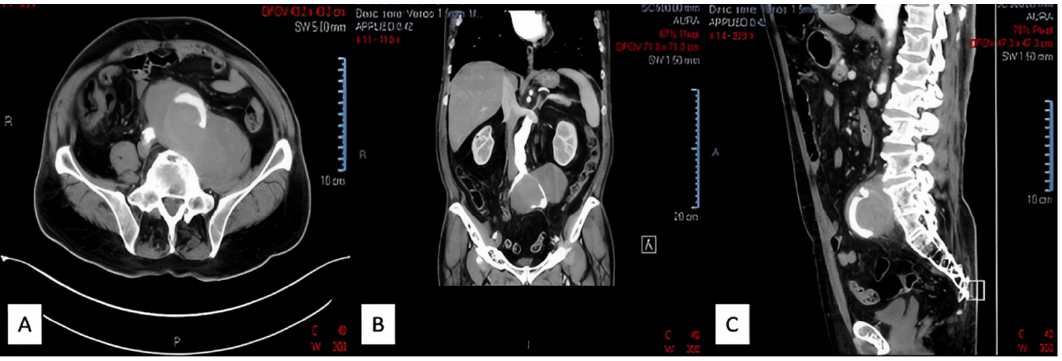
Figure 1. Left common iliac artery saccular aneurysm view: ( A )—transversal; ( B )—coronal; ( C )—sagittal.